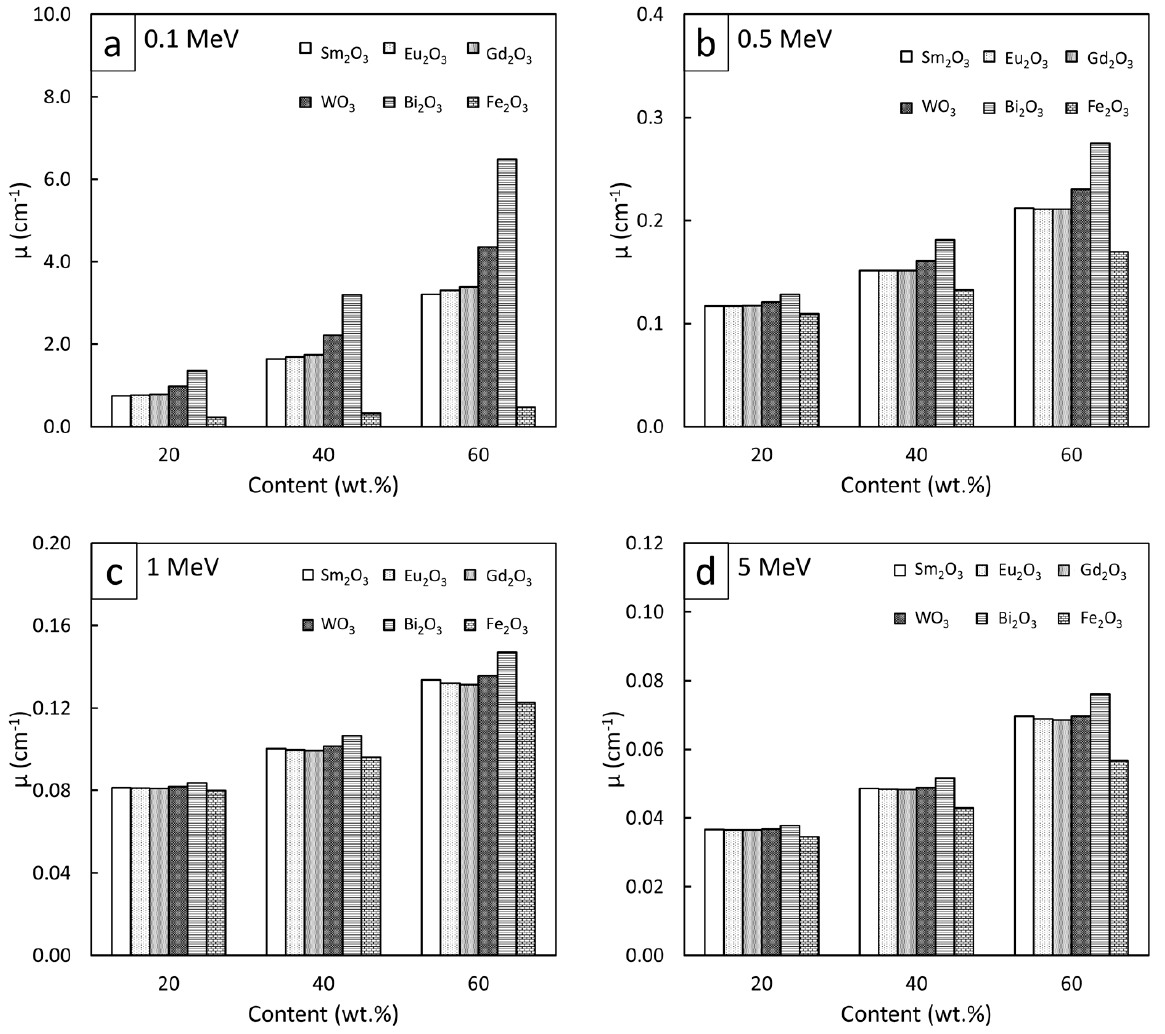
Figure 8. Comparative µ values of Sm 2 O 3 /HDPE, Eu 2 O 3 /HDPE, and Gd 2 O 3 /HDPE composites with other common Pb-free HDPE composites (Bi 2 O 3 /HDPE, WO 3 /HDPE, and Fe 2 O 3 /HDPE) at filler contents of 20, 40, and 60 wt.% and photon energies of ( a ) 0.1 MeV, ( b ) 0.5 MeV, ( c ) 1 MeV, and ( d ) 5 MeV.